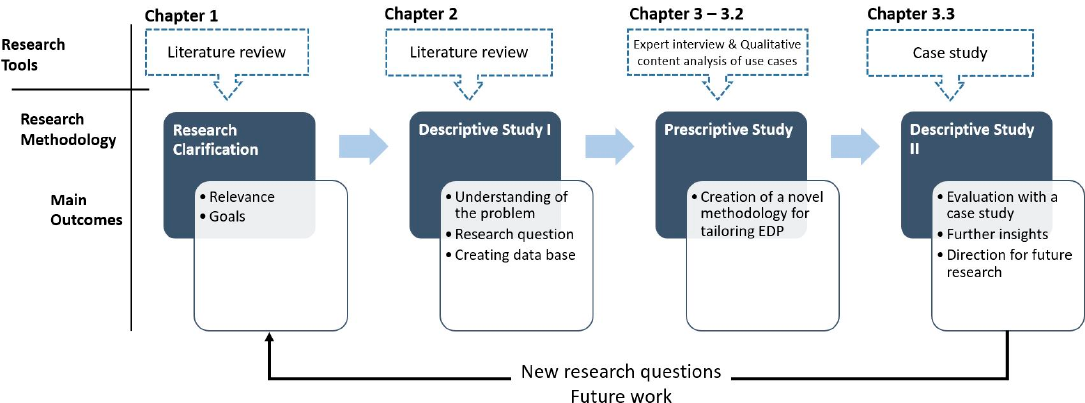
Figure 1. The used design research methodology .